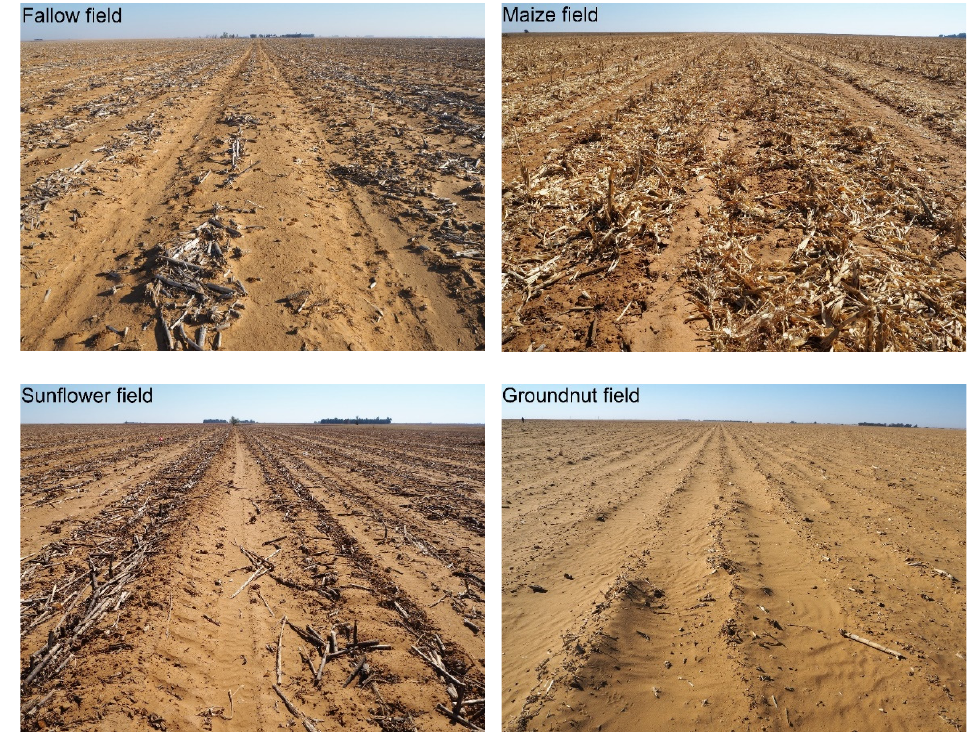
Figure 4. The four fields that were monitored during the field study. Table 1. The height from the laying and standing stubble of the four fields. Field Stubble Laying